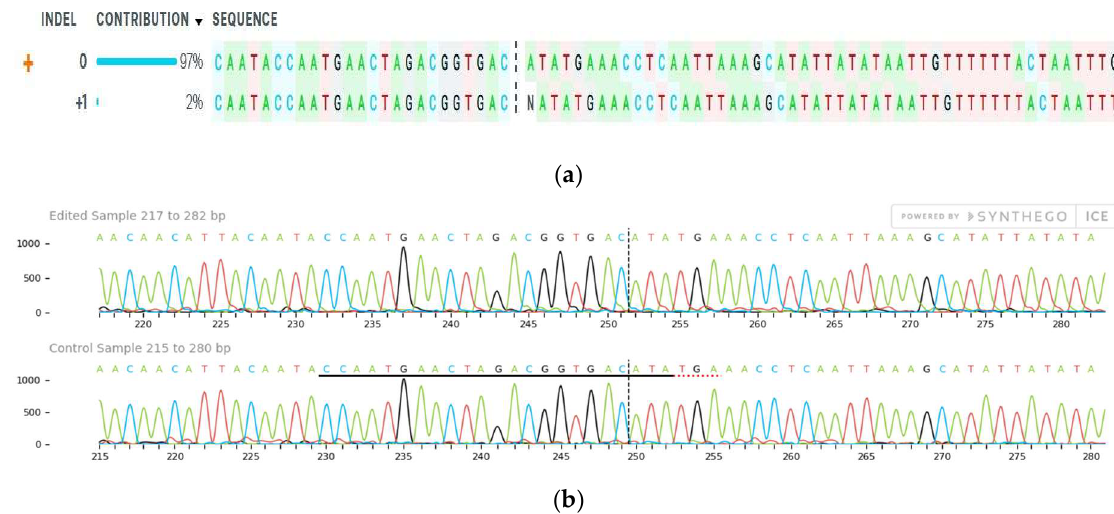
Figure 7. ICE results for 4CL . ( a ) The sequence plot represents the ICE Analysis of 4CL sgRNA1 Target 1 (sgRNA:CCAATGAACTAGACGGTGACATA) RNP edited protoplast cells in the chickpea. The contributions show the sequences inferred in the edited protoplast population and their relative proportions. The cut sites are represented by black vertical dotted lines and “+” far left side denotes the control sample. ( b ) The trace plot of the 4CL sample 4 edited and control population of the protoplast showing the PAM sequence and cut site.